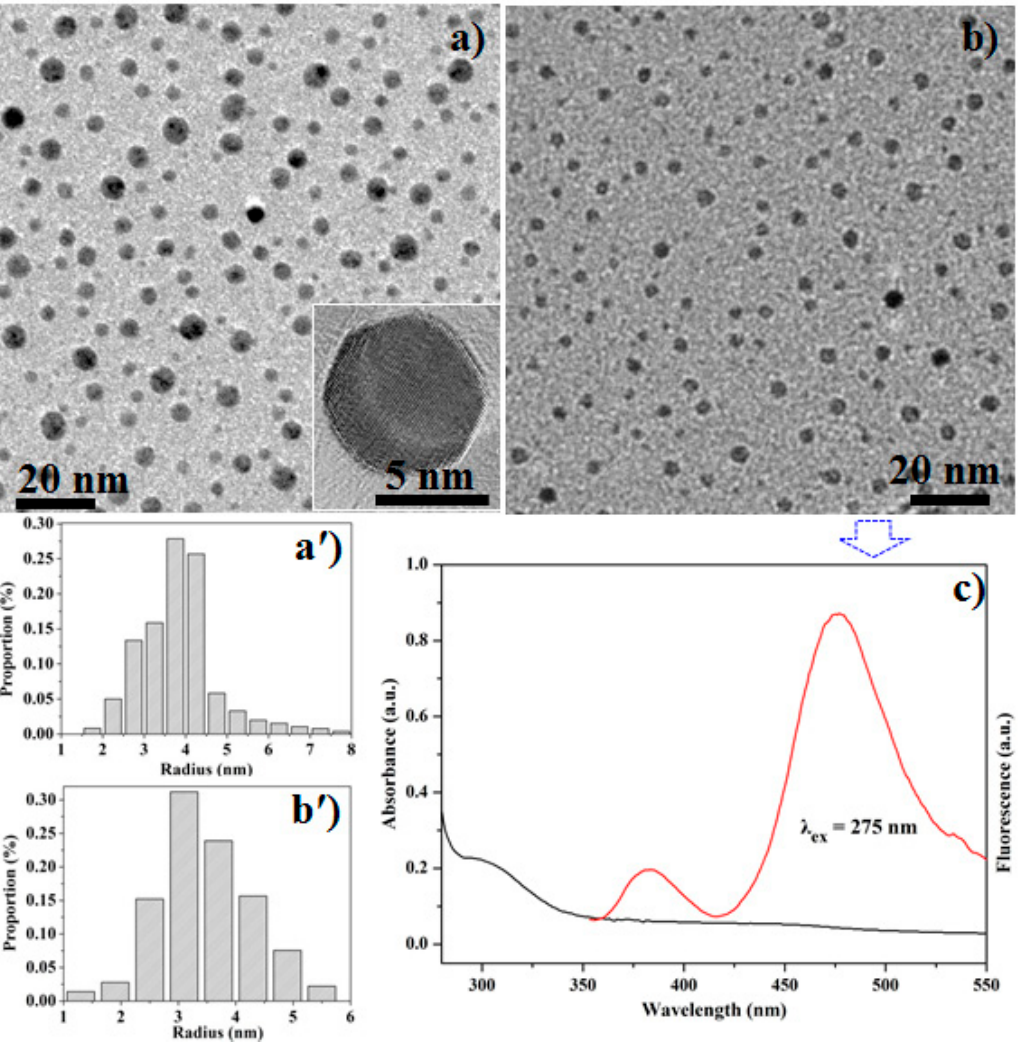
Figure 6. TEM images and size distribution plots of the samples through the batch-sorting process: a, a ʹ ) Q-ZnS-I ʹ -i (3000 rpm); b, b ʹ ) Q-ZnS-I ʹ -ii (4000 rpm), respectively. c ) UV-Vis and photoluminescence spectra of the batch-sorting sample Q-ZnS-I ʹ -ii.